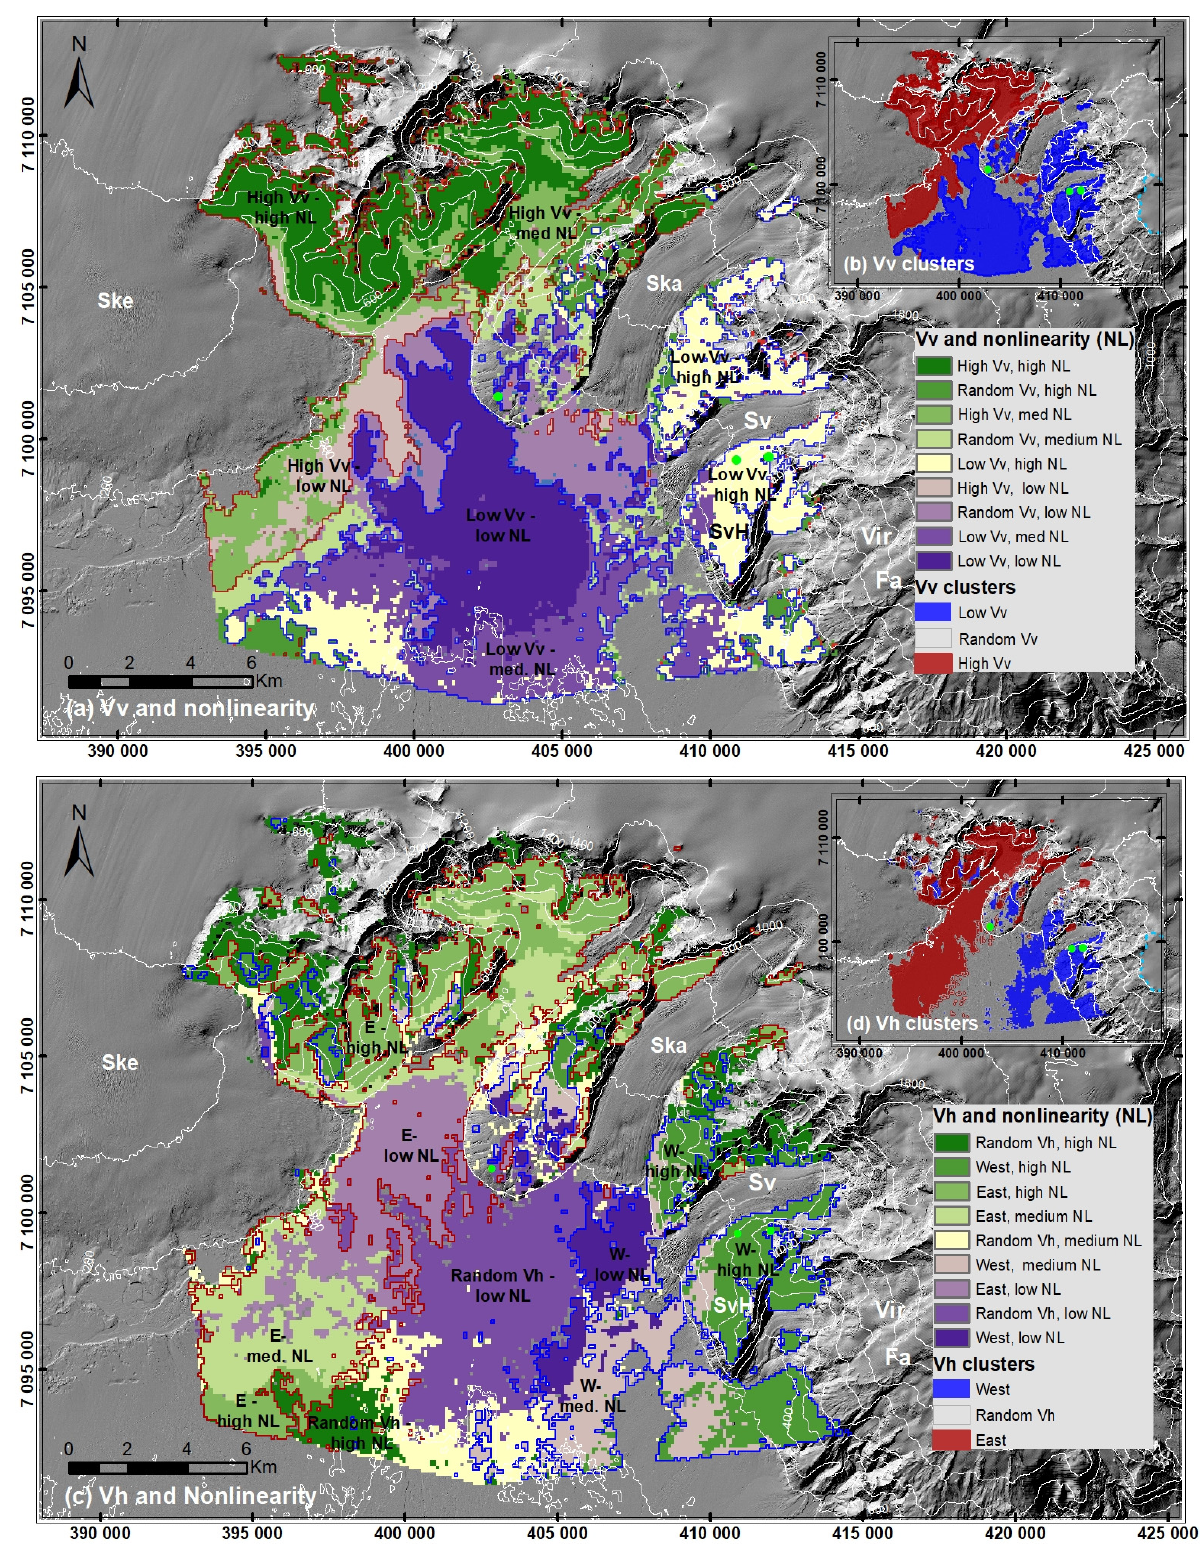
Figure 11. Two-dimensional local deformation velocity zoning as a result of spatial analysis based on two parameters: the velocity component ( V v or V h ) and the std . V los . Each parameter is classified into three clusters, with high, medium, and low values, resulting in nine unique deformation velocity (UDV) zones. ( a , c ) show the V v zones and the V h zones, respectively; ( b , d ) insets illustrate V v and V